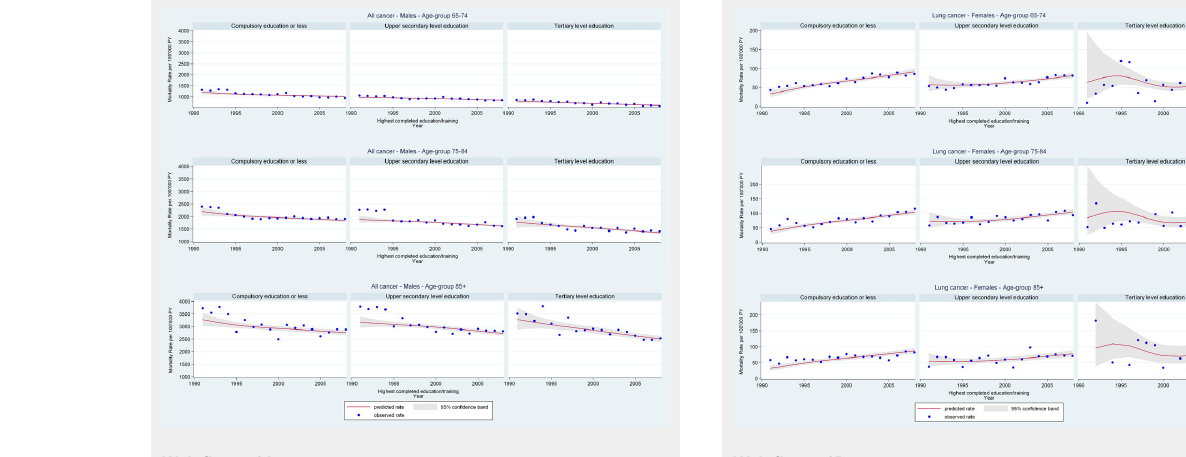
Age-specific all-cancer mortality rates from 1991 through 2008 for older Swiss men (≥65 years old) by education